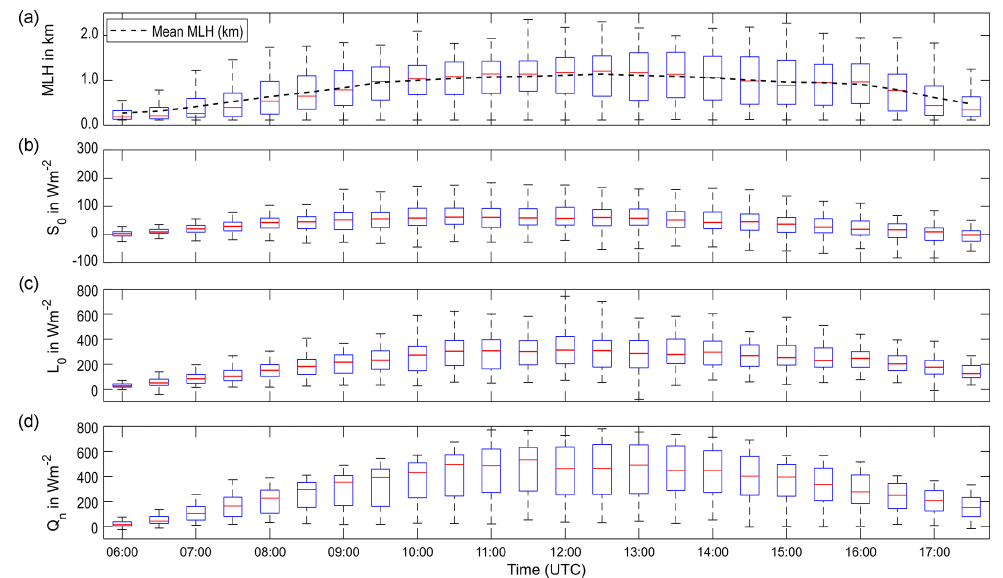
Figure 6. Statistics of the diurnal cycle between 06:00 and 18:00UTC of mixing layer height (MLH) (a) , surface sensible heat flux ( S 0 ) (b) , latent heat flux ( L 0 ) (c) and net radiation ( Q n ) (d) for 3 months from May to July 2021.